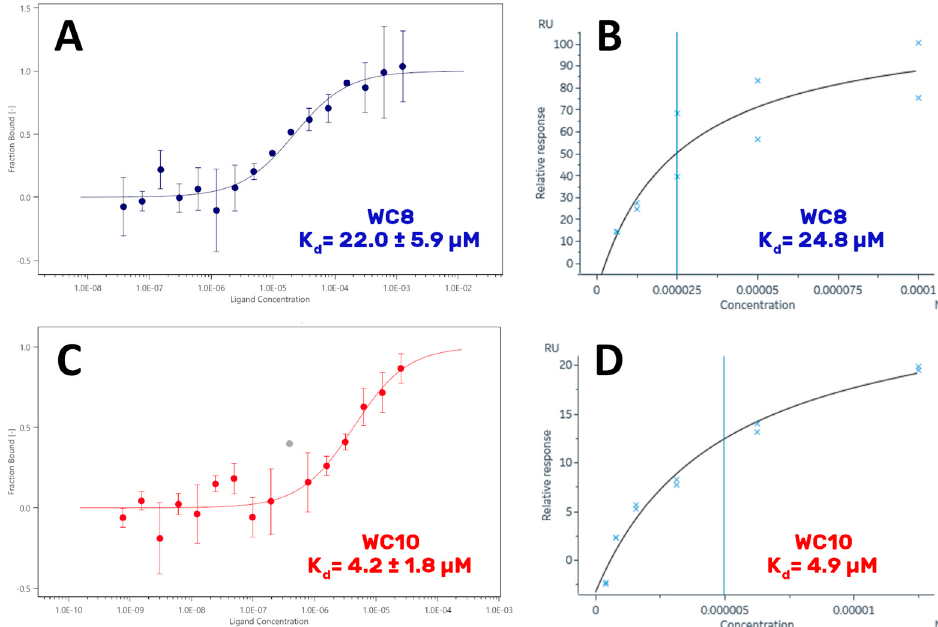
Figure 5. Binding of WC8 and WC10 to GABARAP. MST and SPR curves acquired by recombinant GABARAP incubated with different concentrations of WC8 ( A , B ) and WC10 ( C , D ) peptides. In the MST plot referred to WC10 ( C ), the point corresponding to a concentration of 391 nM (evidenced in gray) appears to be a clear outlier, also considering the other experiments; hence, it was discarded and not included in the calculation of the K d value.